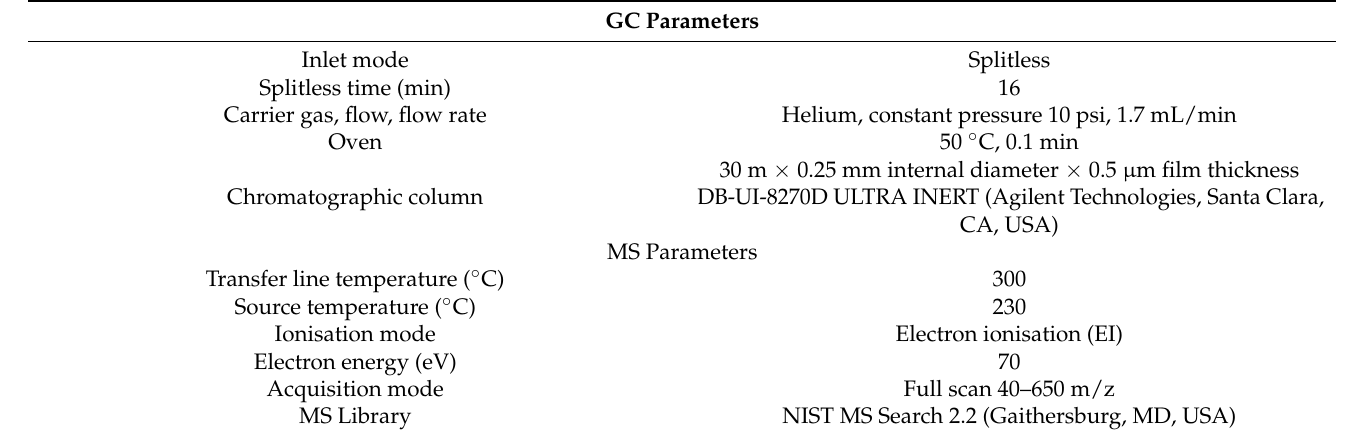
Table 2. GC/MS parameters for the determination of SVOCs in KH.